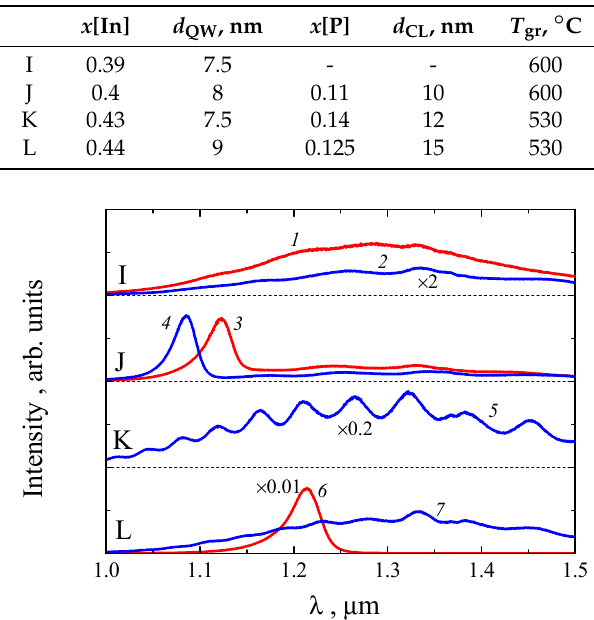
Table 3. Characteristics of samples with heavily strained InGaAs QWs and GaAsP Strain-compensating layers. Sample name (capital letter), In fraction in the QW ( x [In]), QW thickness ( d QW ), P fraction in the strain-compensating layers ( x [P]) and their thickness ( d CL ), as well as the growth temperature ( T gr ) are indicated in the corresponding columns.